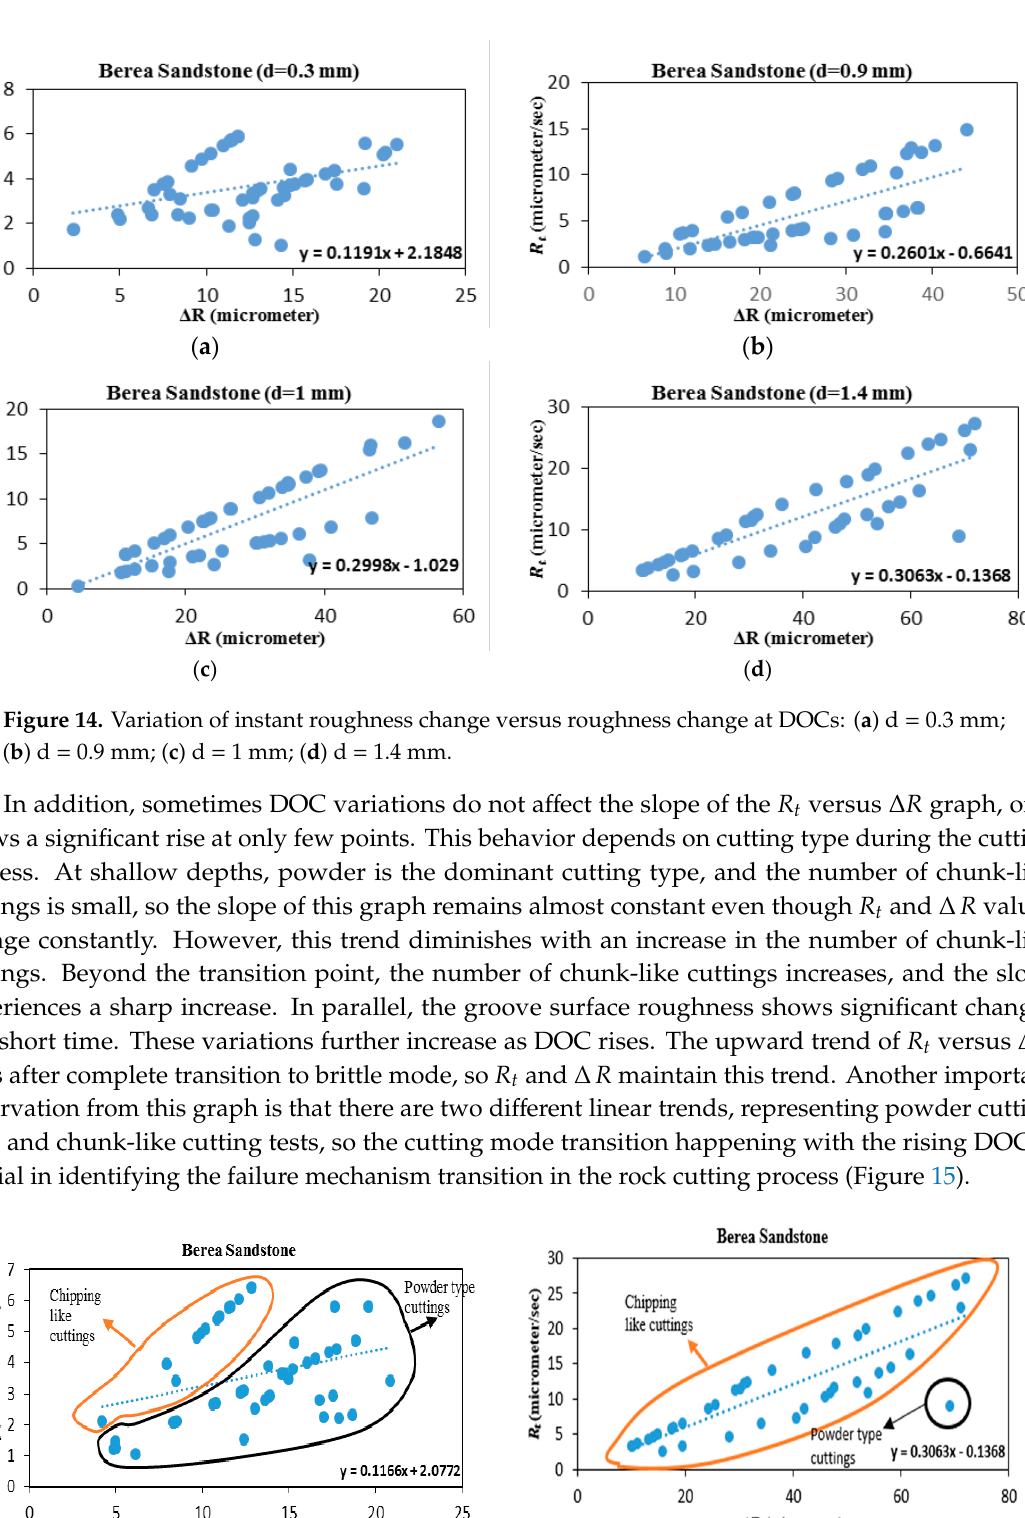
( d ) Figure 13. Reproduced groove surfaces with increasing DOC: ( a ) d = 0.4 mm; ( b ) d = 0.8 mm; ( c ) d = 1 mm; ( d ) d = 1.2 mm. The 𝑅 𝑡 , which presents the average change in the surface roughness, is calculated along the grooved path and then 𝑅 𝑡 versus ∆𝑅 graphs are used to better illustrate surface topographic variations (see Figure 14). If 𝑅 𝑡 and ∆𝑅 are small, it means that the cutter scratches the rock surface in powders, which is a result of the ductile mode failure. As illustrated in Figure 14a, shallow DOCs